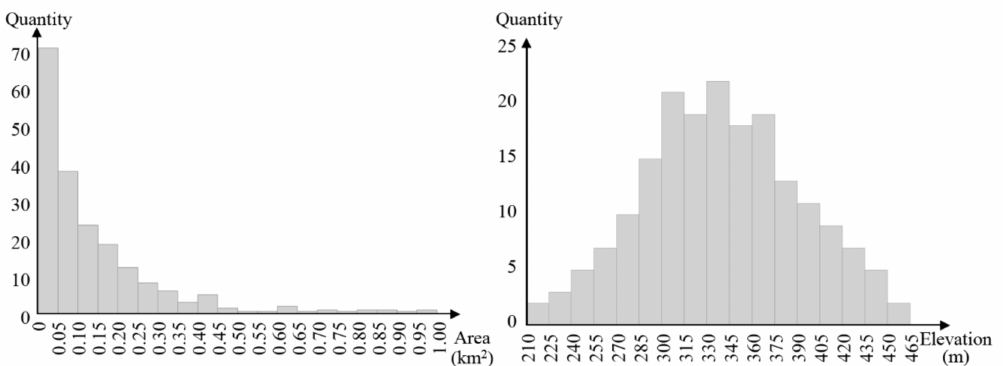
Figure 9. Area histogram and surface elevation histogram of